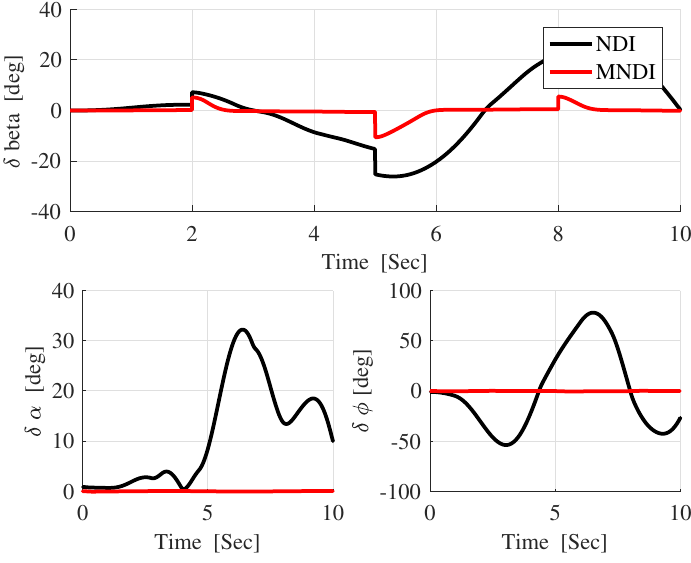
Figure 22. Attitude angle error for outer side-slip angle excitation with wind and